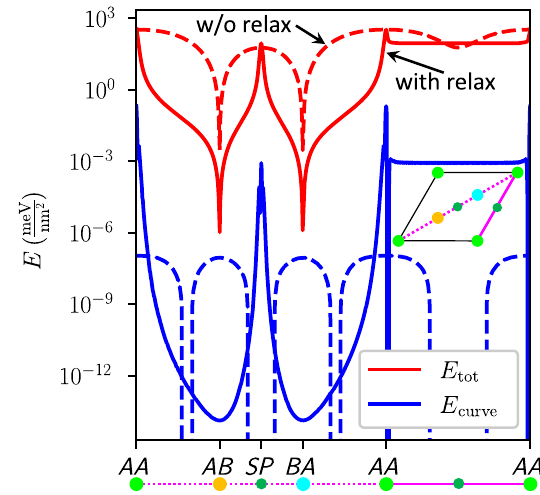
FIG. 8. Effects of curvature on atomic relaxation process in twisted-bilayer graphene. Comparing total energy density (red) to the elastic energy term resulting from membrane bending (blue; more details in the text) before and after relaxation (dashed and solid lines, respectively) as a function of the original (before relaxation) stacking configuration (on a path in configuration space indicated in the inset). The out-of-plane displacement is taken to be the layer spacing at the local configuration as presented in Table III of Ref. [94] (and independently